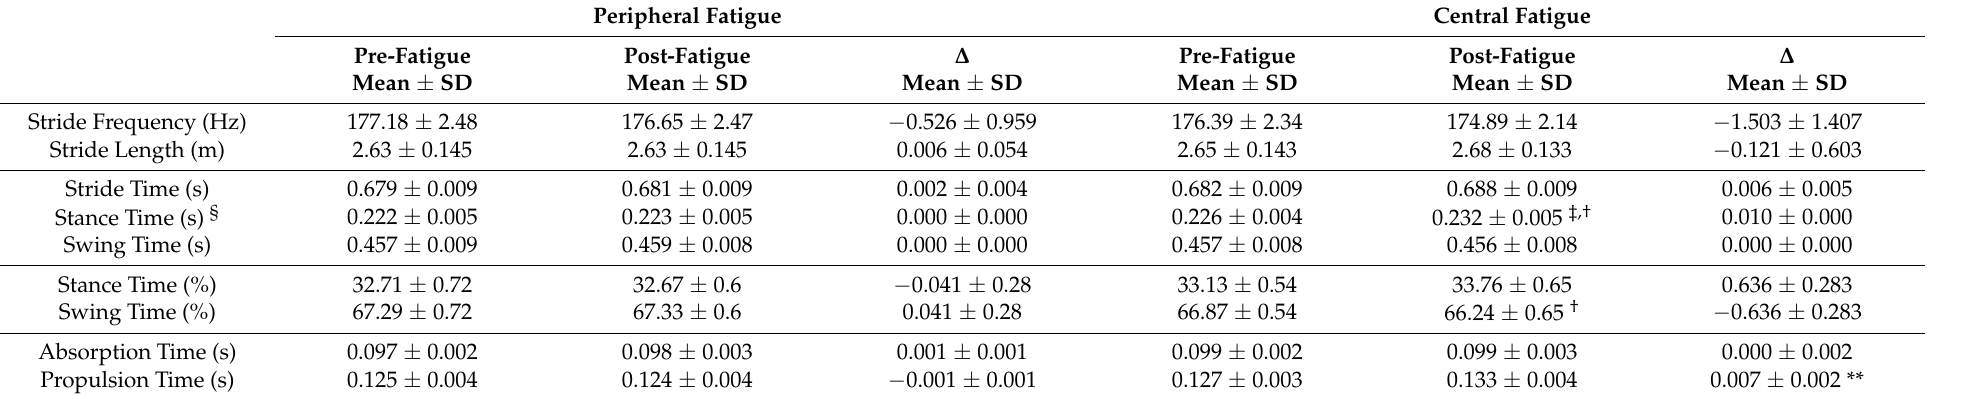
Table 2. Results of spatiotemporal parameters and spring-mass model pre- and post-fatigue. Peripheral